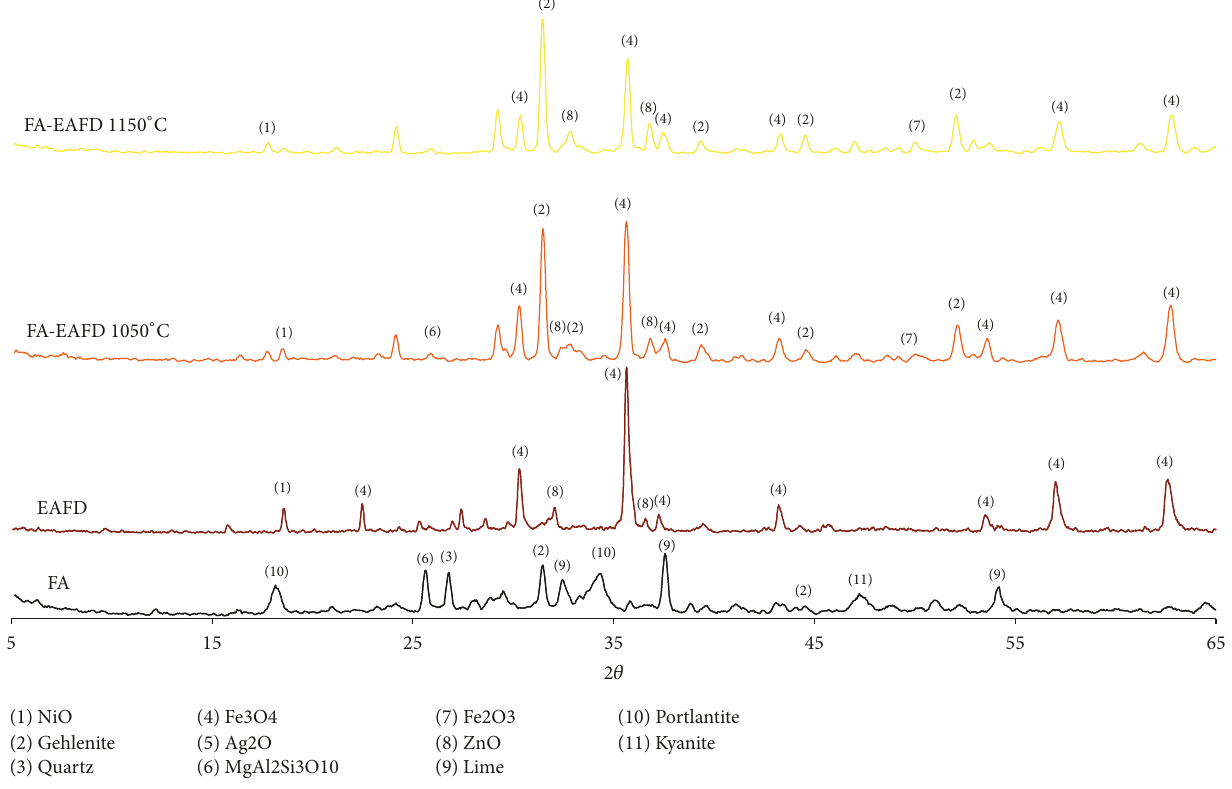
Figure 3: XRD patterns of the FA, EAFD (sintered at 1050 ∘ C), and its mixture, sintered in two different temperatures: 1050 and 1150 ∘